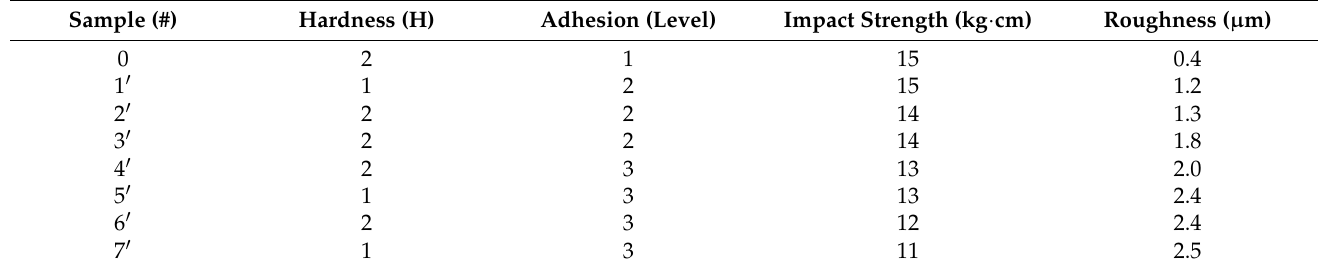
Table 9. Mechanical characteristics of the coating film applied to the andoung